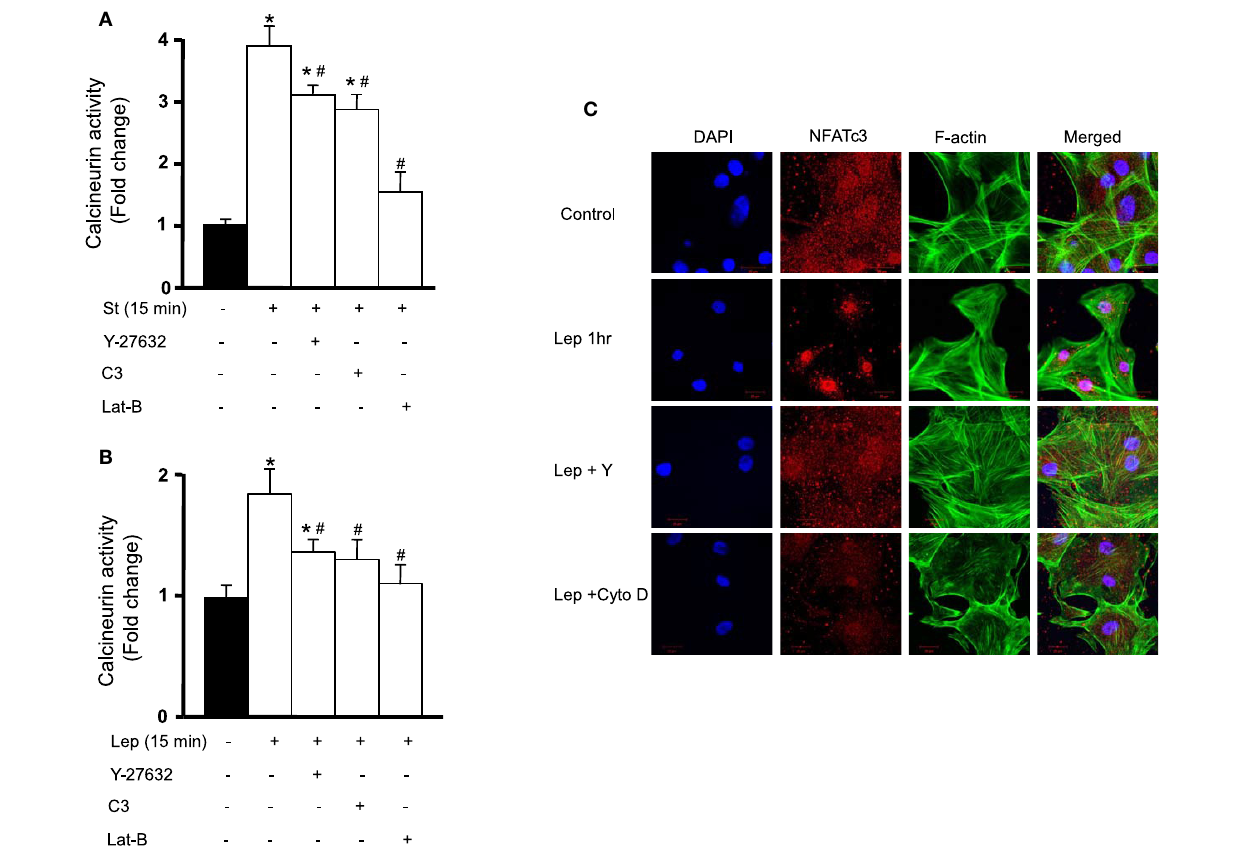
FIGURE 4 | Calcineurin/NFAT activation is mediated by the RhoA/ROCK pathway. (A) RPVs were pre-treated with either the selective RhoA inhibitor C3 (30ng/mL) or the selective ROCK inhibitor Y-27632 (10 µ M) and mechanically stretched for 15min. Calcineurin activity was measured by detecting its phosphatase activity. C3 and Y-27632 compound each significantly reduced calcineurin activity. The actin depolymerization agent latrunculin B (Lat-B; 50 nM) also significantly decreased stretch-induced activation of calcineurin ( n = 8). * p < 0.05 vs. unstretched. # p < 0.05 vs. St 15min. (B) C3, Y-27632, and Lat-B each significantly reduced calcineurin activation in response to leptin (3.1nM) treatment for 15min ( n = 8). * p < 0.05 vs. untreated. # p < 0.05 vs. Lep 15min. (C) Laser confocal microscopic images ( n = 4) of RASMCs reveal that NFAT nuclear translocation in response to 1h leptin treatment (3.1nM) was abolished by Y-27632 compound and cytochalasin D (Cyto D; 1 µ